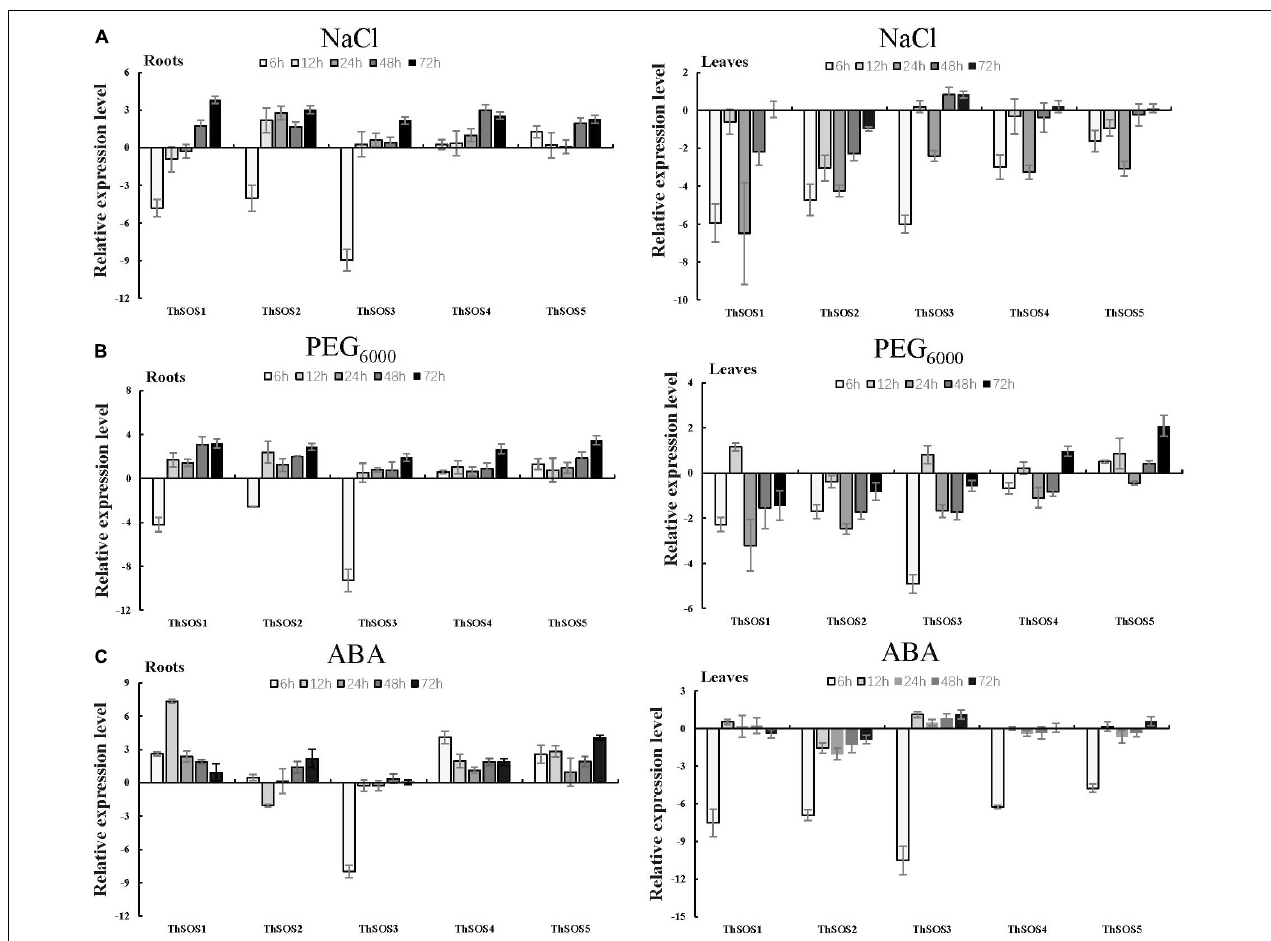
FIGURE 2 | Expression analysis of the 5 ThSOS genes in the roots and leaves in response to abiotic stresses (NaCl and PEG 6000 exposure) and hormone (ABA) treatment. (A) 0.4 M NaCl. (B) 20% (w/v) PEG 6000 . (C) 100 µ M ABA. All relative transcription levels were log2-transformed. The error bars were obtained from multiple replicates of